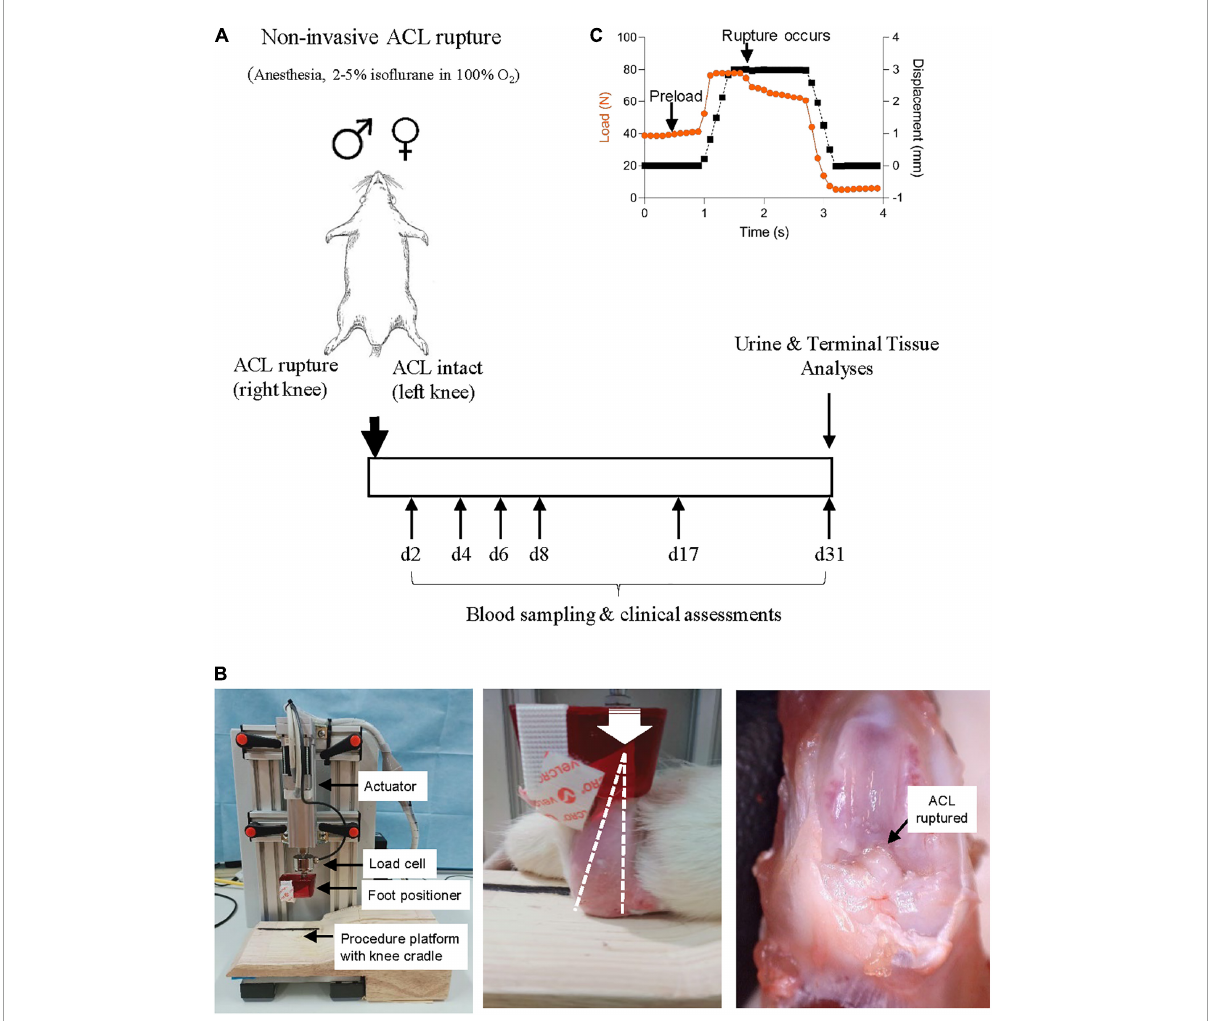
FIGURE1 (A) Study protocol schematic. Non-surgical ACL rupture was performed on the right knee of anesthetized male and female Sprague Dawley rats. Left knees underwent sham injury, with the ACL remaining intact. At day 31 post-ACL rupture, animals were euthanized for terminal tissue analyses. (B) Custom non-surgical rat ACL rupture apparatus (left panel). The anesthetized animal was placed in a prone position on the procedure platform, the right hind limb secured with the knee in 100 ◦ flexion (white dotted line, middle panel) and the ankle in 30 ◦ dorsiflexion within the foot positioner. A compressive load was applied through the knee (white arrow indicates direction of load) at 8 mm/s with a displacement of 2.5–3 mm, resulting in ACL rupture (black arrow, right panel). (C) ACL rupture is evident by a quasi-instantaneous drop in load on the data